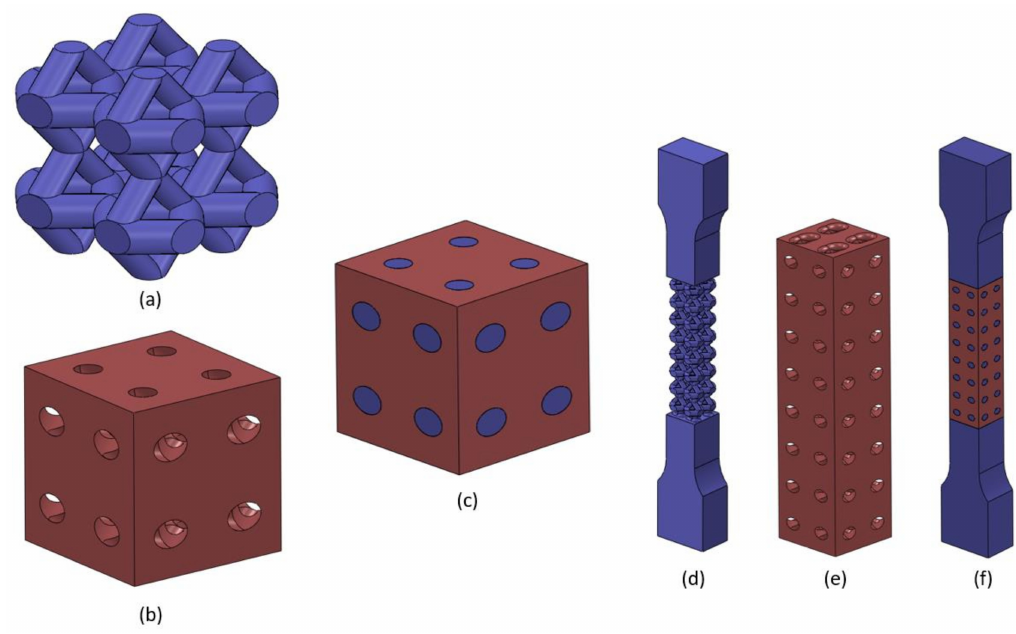
Figure 13. CAD models of the composite parts: ( a ) lattice part for the compression composite; ( b ) matrix part for the compression composite; ( c ) the compression composite; ( d ) lattice part for the tension composite; ( e ) matrix part for the tension composite; ( f ) the tension